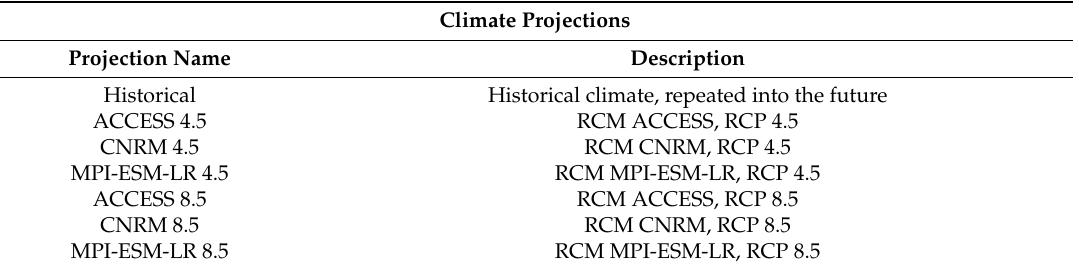
Table 6. Climate projections and management strategies incorporated into the model to develop 112 scenarios.